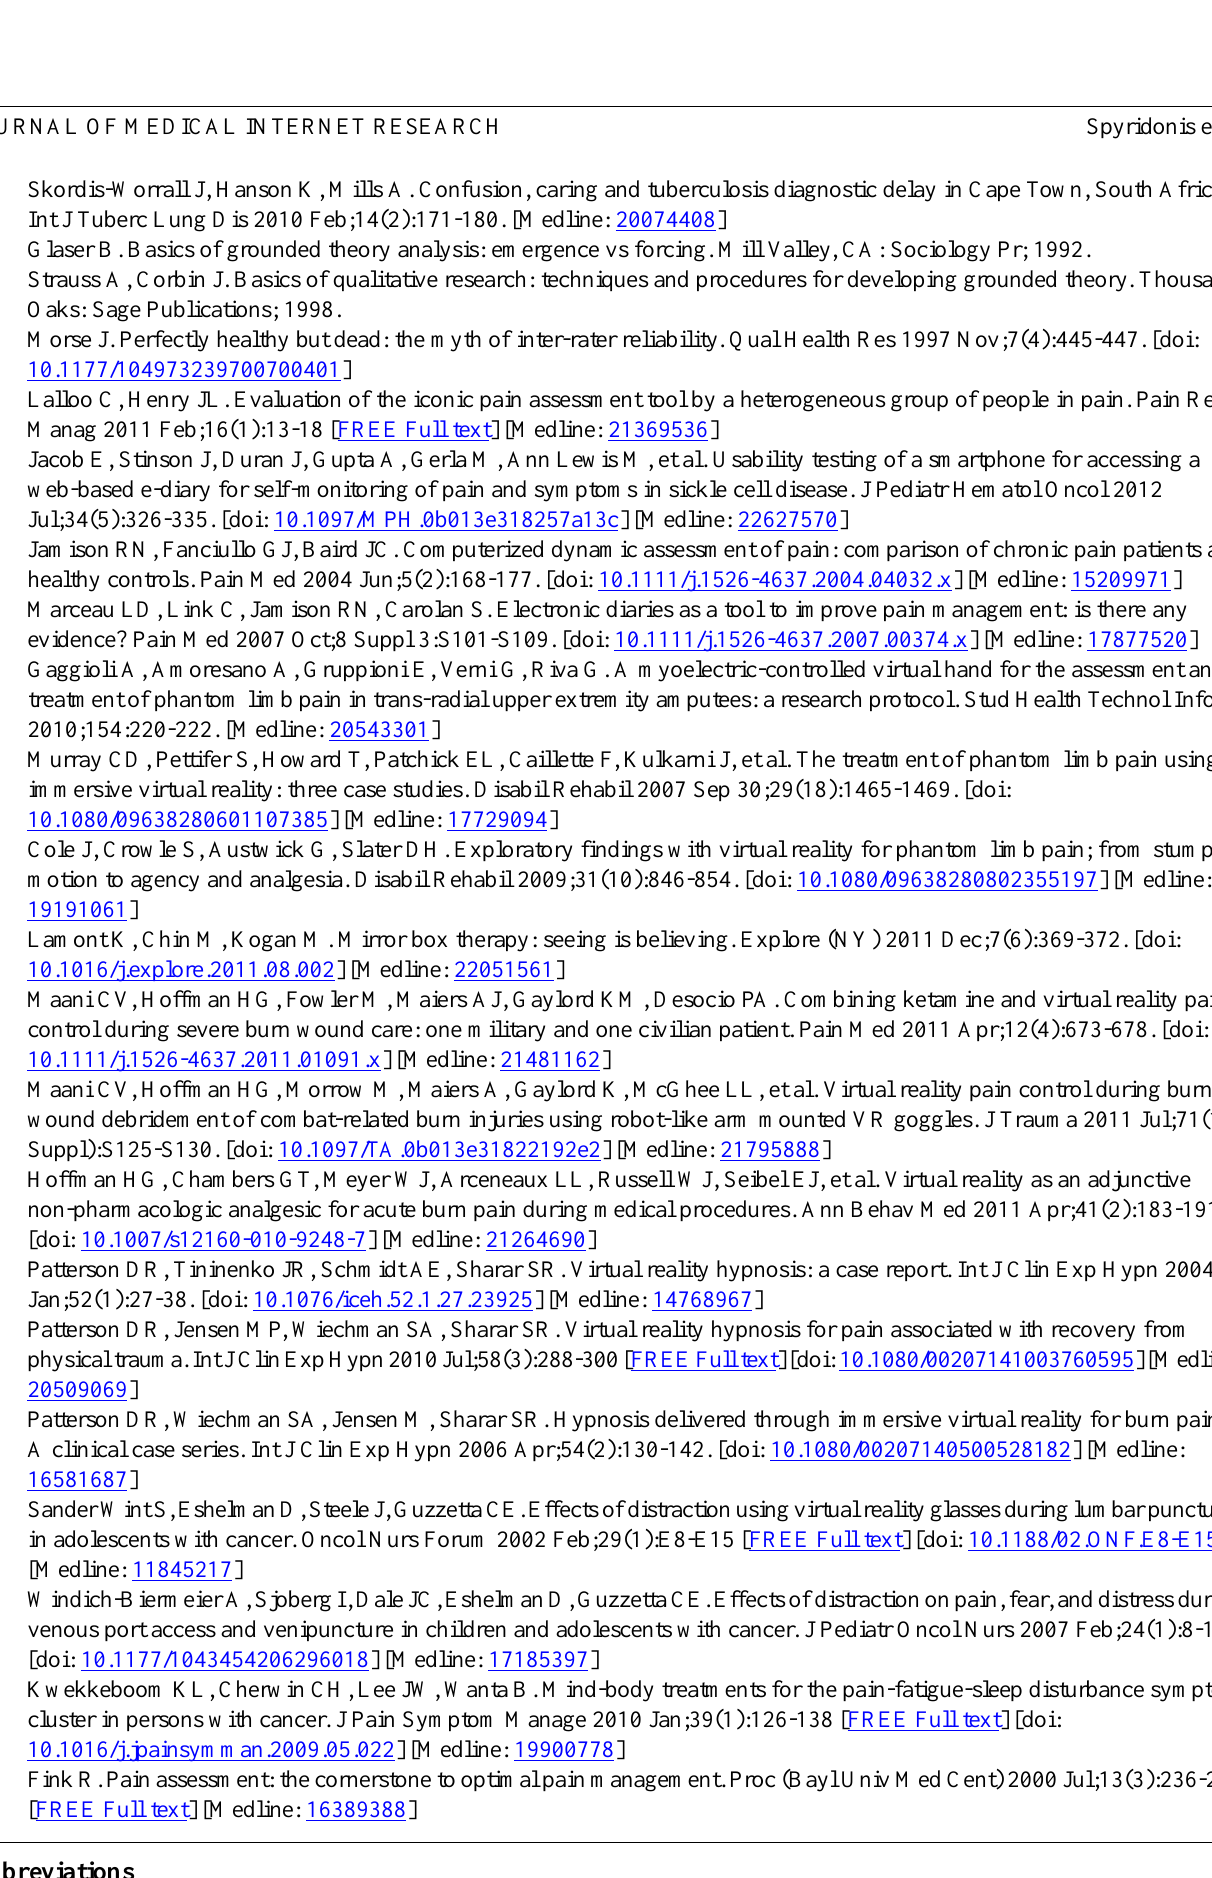
Abbreviations 2D: